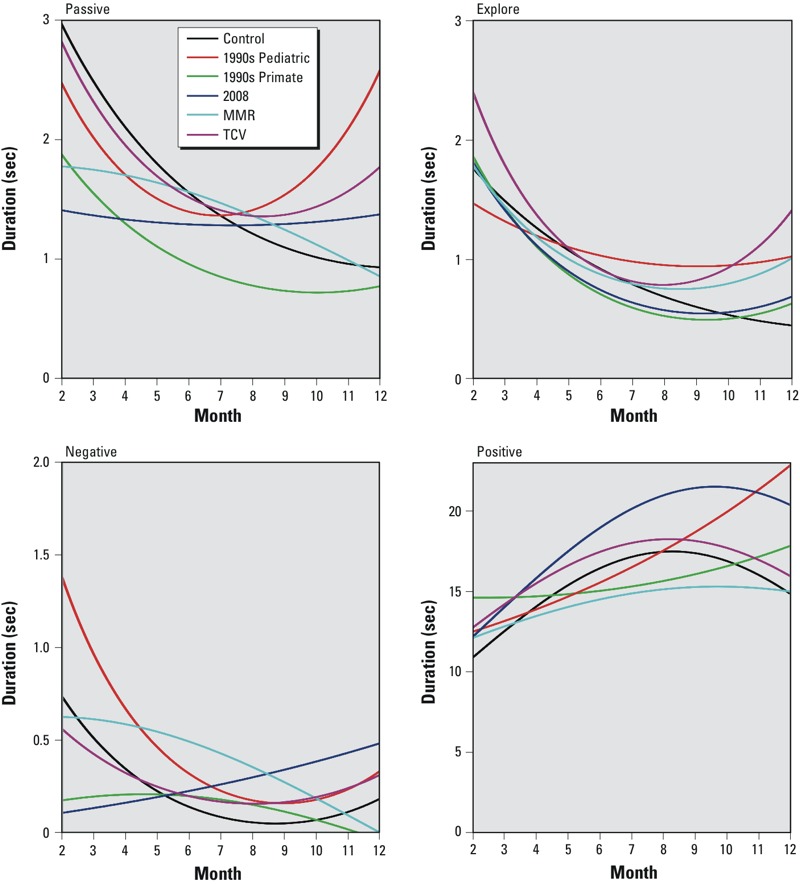
Fitted values from analytical models of social behavior for all groups from 2–12 months of age.